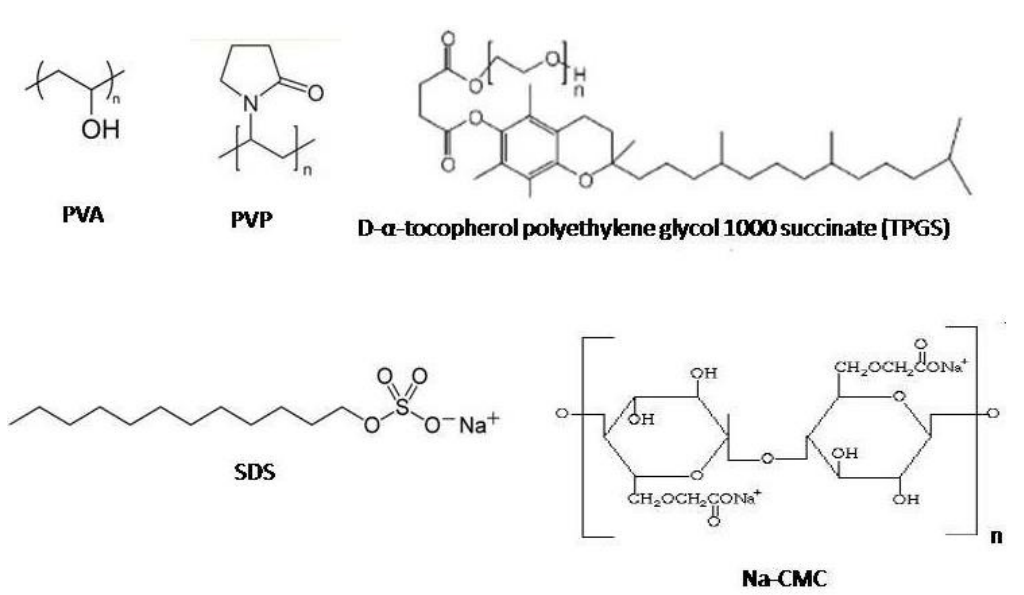
Figure 5. Chemical structures of stabilizers used in this study, with molecular surface charge provided.